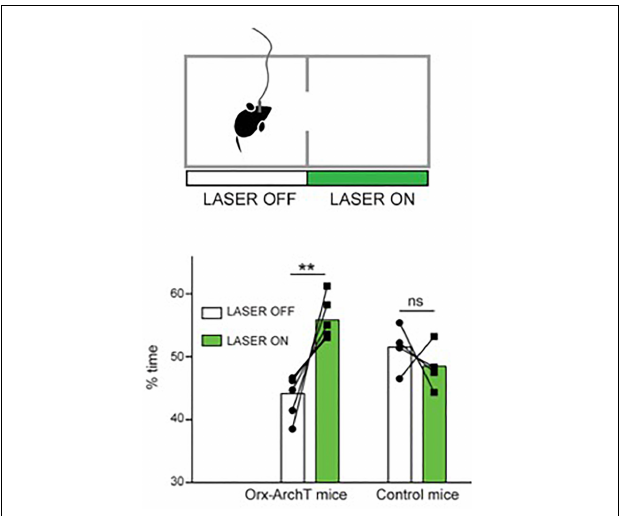
FIGURE 2 | Role of natural orexin cell activity in spatial avoidance. Optogenetic silencing (“LASER ON”) of orexin-ArchT neuron in one half of exploration arena causes mice to spend more time in that half. Source: Garau et al.